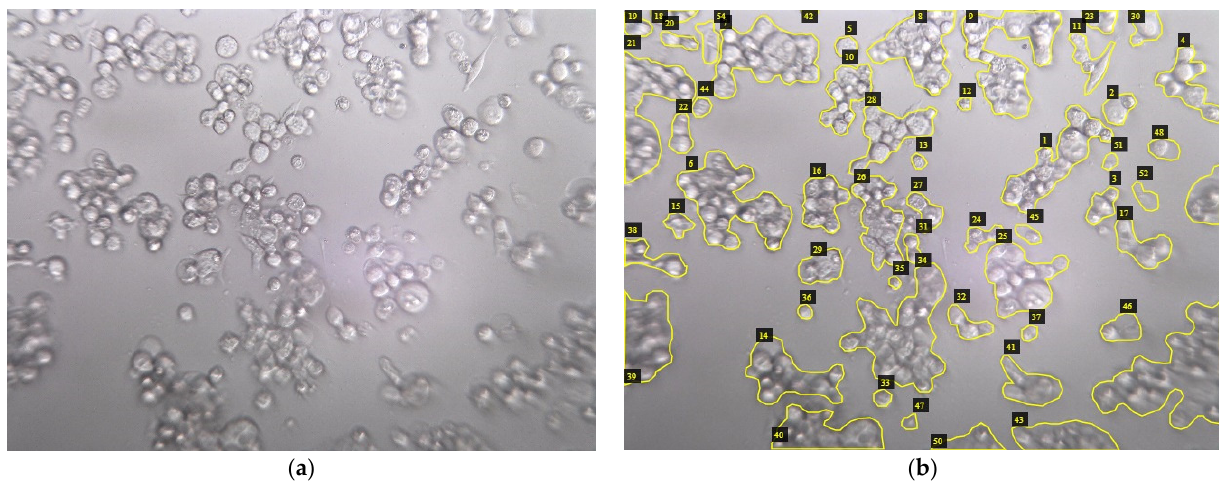
Figure 3. The MCF7 breast cancer cell line. ( a ) Image from Dataset 2—CPT_24H_72H; ( b ) manual segmentation of cell regions.